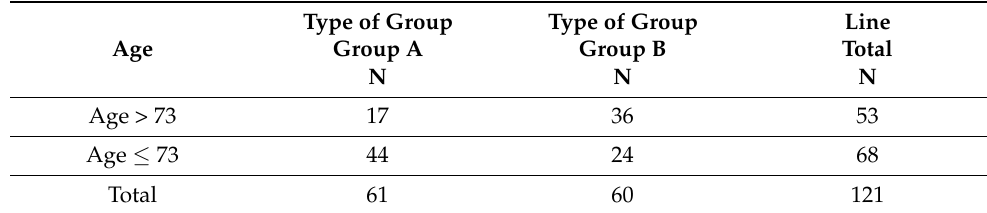
Table 3. Size in both groups according to age distribution.